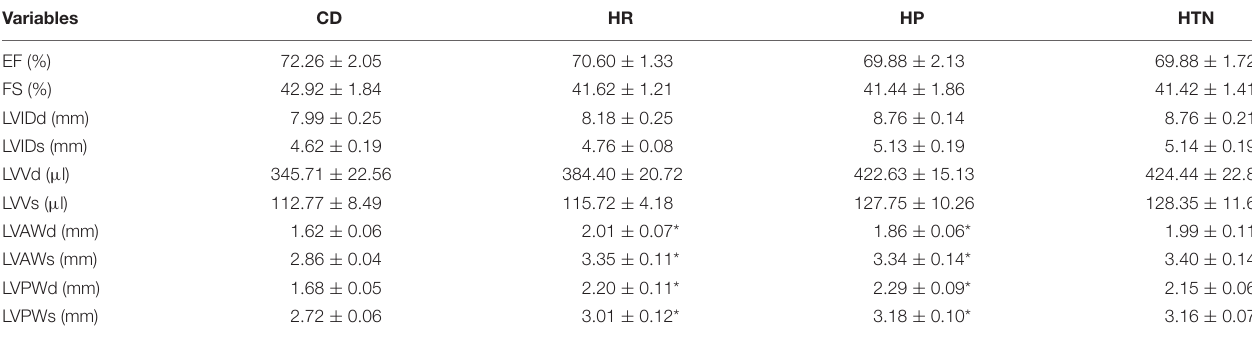
TABLE 3 | Cardiac function of rats with CD or HSD.